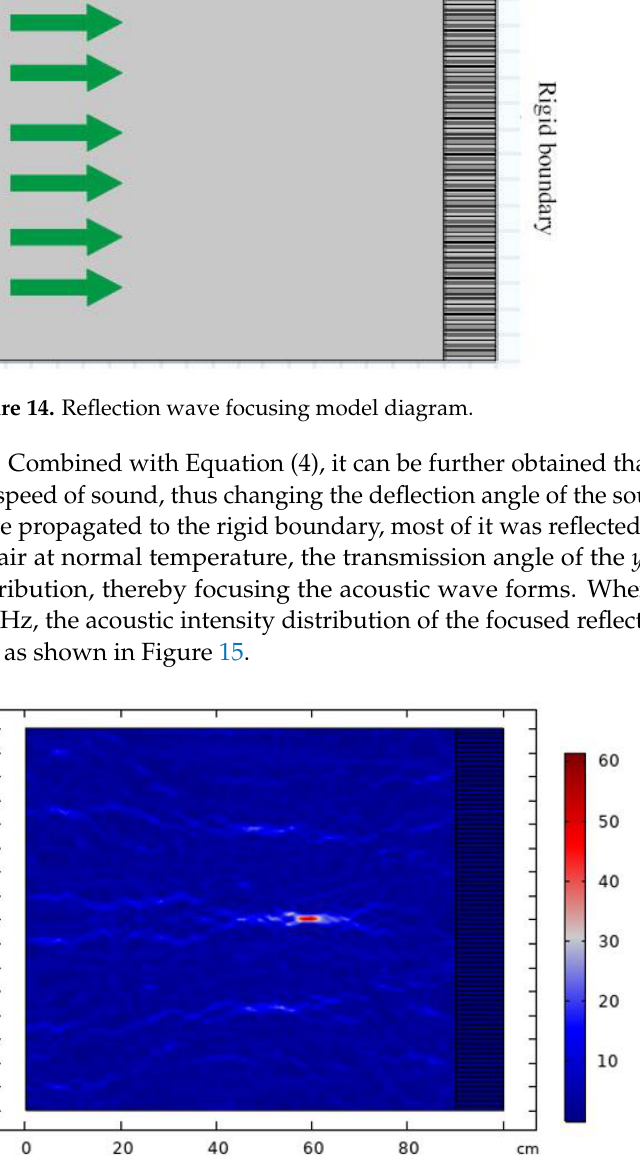
Figure 15. Spatial distribution of acoustic intensity field through focusing lens at 20 kHz.